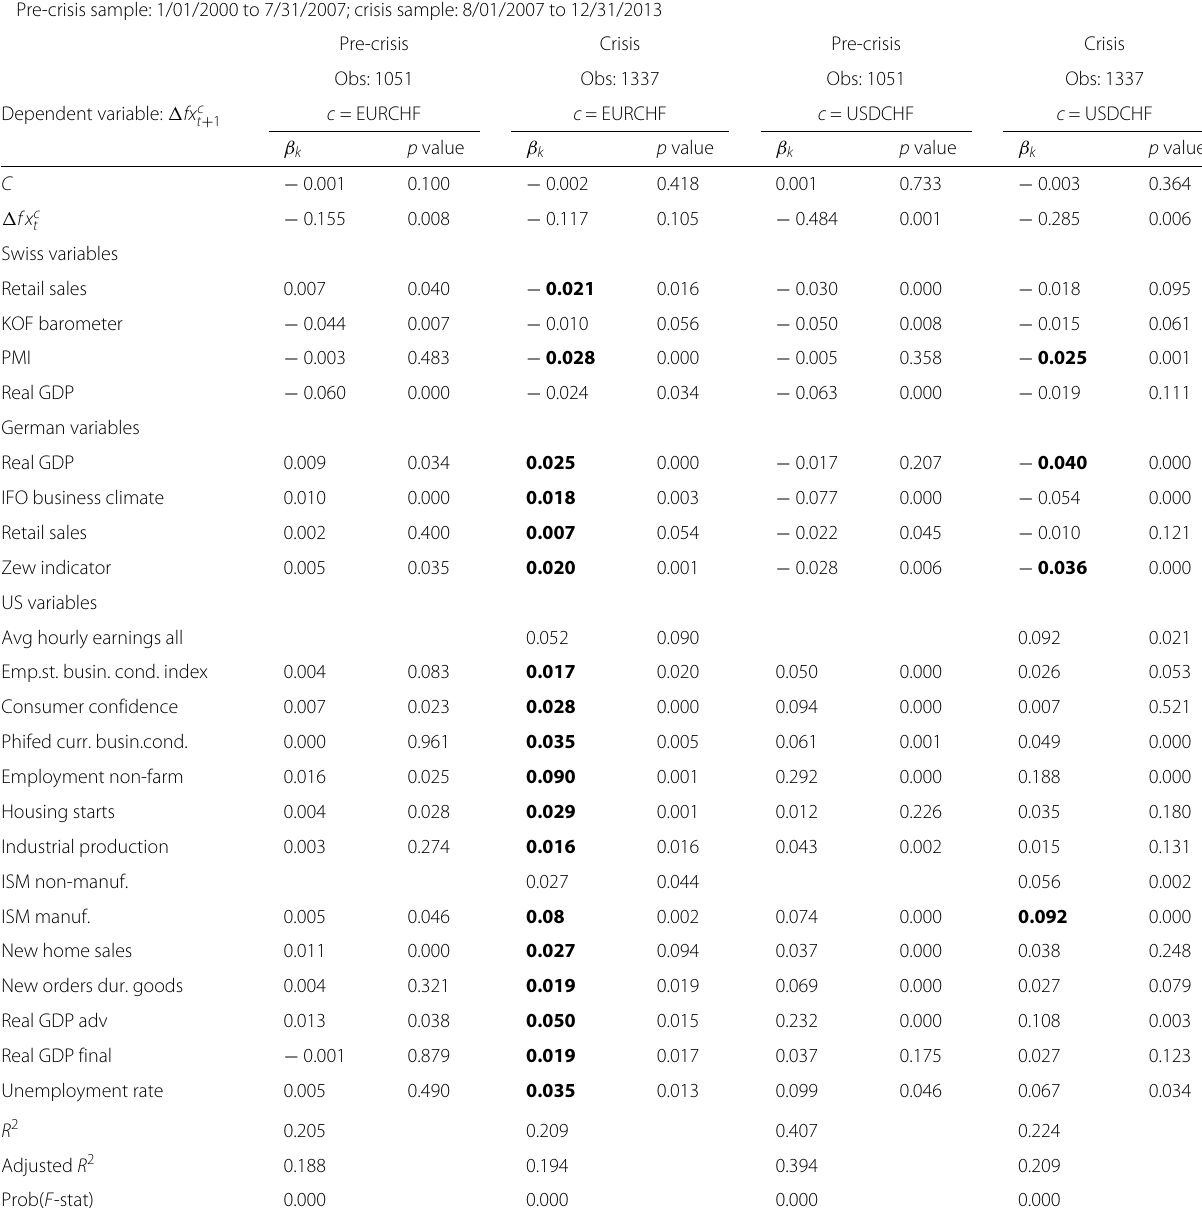
Table 3 Crisis vs. pre-crisis for the